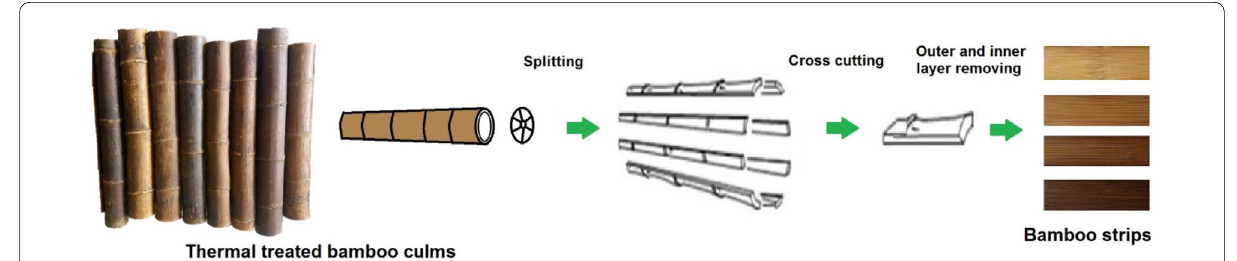
Fig. 1 Bamboo strips preparation for